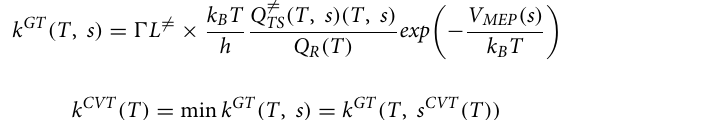
functions (see Supporting Information, Table S3). Intrinsic reaction coordinate (IRC) calculations were car- ried out at M06-2X/6–311++G(3df,3pd) level to confirm the identities of the reactants and products for every transition state. Single point energy calculations were calculated using CCSD(T)/6–311++G(3df,3pd) level of theory 36–39 (see Supporting Information, Table S4) on M06-2X/6–311++G(3df,3pd) optimized geometries. The combination of CCSD(T)/6–311++G(3df,3pd)//M06-2X/6–311++G(3df,3pd) (designated CC//M06) has been tested by many research groups 20,33–35 and shown to be reasonably accurate. T1 diagnostic was computed using CCSD(T)/6–311++G(3df,3pd) for all important species was < 0.017, which is acceptable for a single ref- erence wave function 40 . The T1 diagnostic for all the species involved in the reaction are given in Supporting Information Table S5. Gaussian 09 suite of programs was used for all ab initio/density functional theory (DFT) calculations 41 . Kinetics. High‑pressure limit rate constants. The high-pressure limit rate constants for title reaction were calculated using canonical variational transition state theory with small curvature tunneling correction (SCT). The generalized rate constants were calculated by minimizing the transition state dividing surface along the reaction coordinate to get the canonical variational transition state theory (CVT) rate constants, which is given by Eqs. (5) and (6):